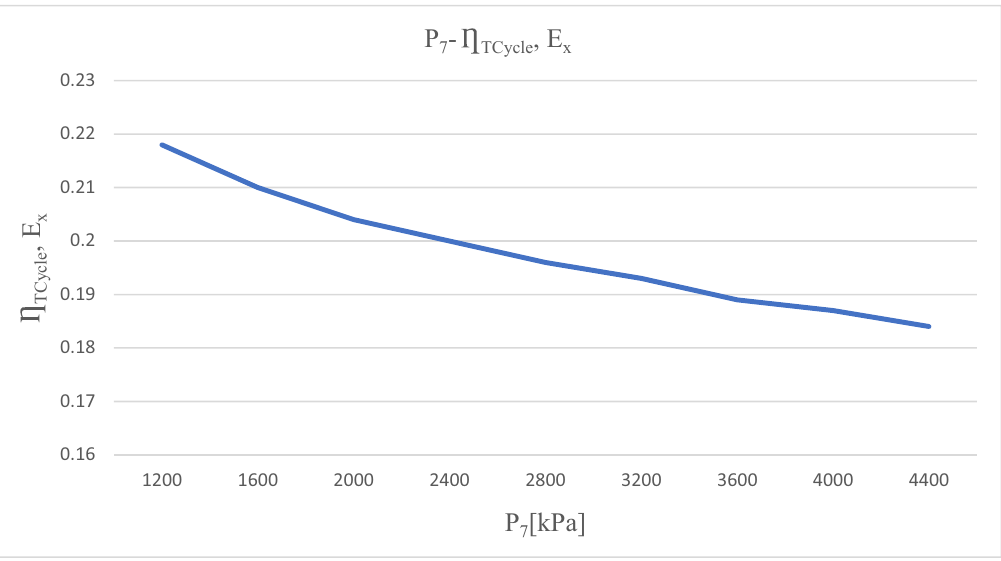
Figure 12: Exergy e ffi ciency curve of the entire cycle obtained for di ff erent outlet pressures at which the second - stage compressor of the vapor compression three - stage cascade cryogenic cycle can